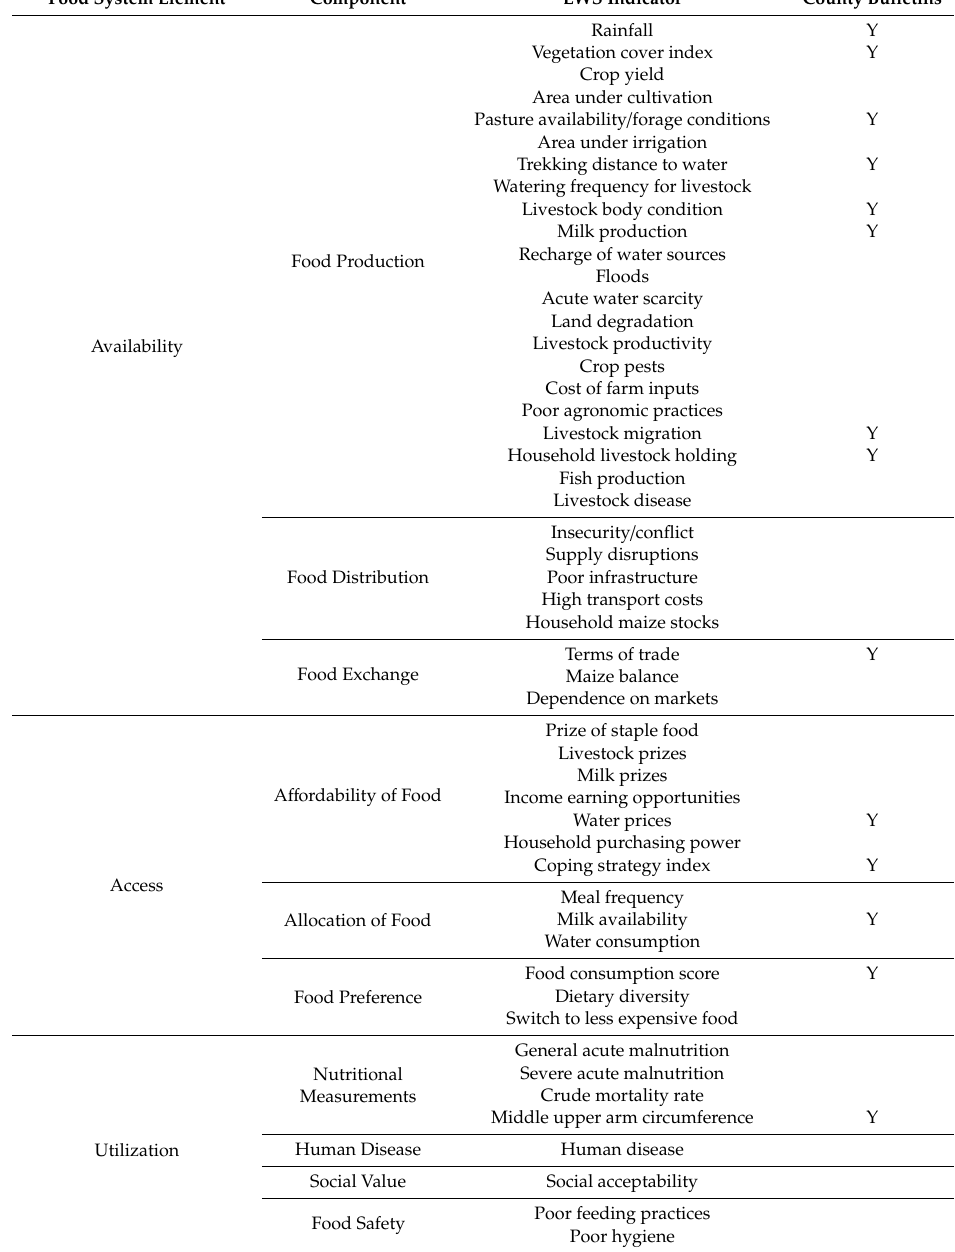
Table 1. Early warning indicators used in NDMA / KFSSG biannual assessment and Turkana drought county